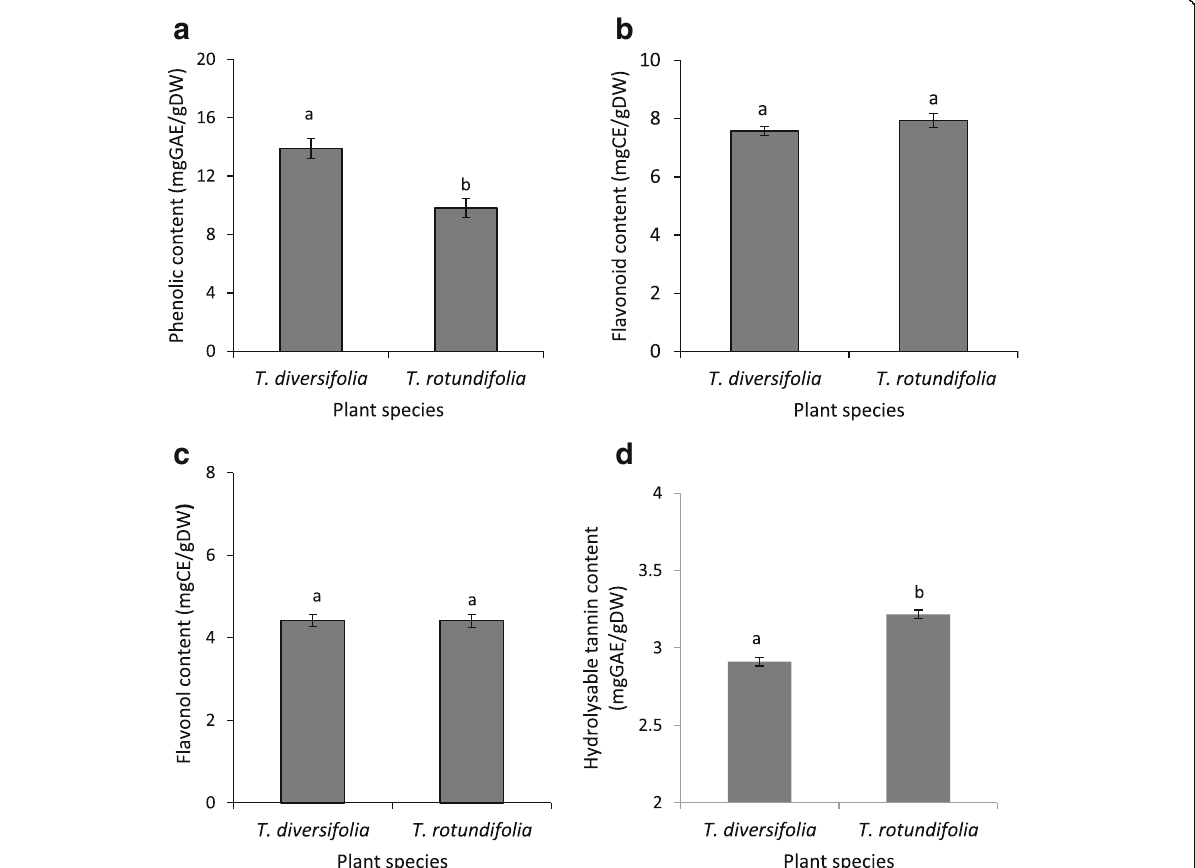
Fig. 1 ( a ) Total phenolic content, as gallic acid equivalents, quantified in the leaves of Tithonia diversifolia and T. rotundifolia ( b ) total flavonoid content as catechin equivalents quantified in the leaves of T. diversifolia and T. rotundifolia ( c ) flavonol content as catechin equivalents quantified in the leaves of T. diversifolia and T. rotundifolia ( d ) hydrolysable tannin content as gallic acid equivalents quantified in the leaves of T. diversifolia and T. rotundifolia . Values in bars are means ±SEM. Sample sizes are given in parenthesis. DW = dry weight; GAE = gallic acid equivalents; CE = catechin